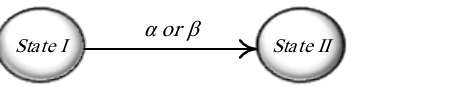
Figure 9. Markov chain model for the conventional HERIC and H5 Inverters.